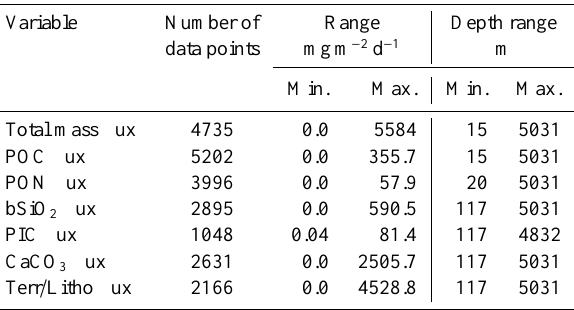
Table 2. Sinking material flux range, depth range distribution and number of data points